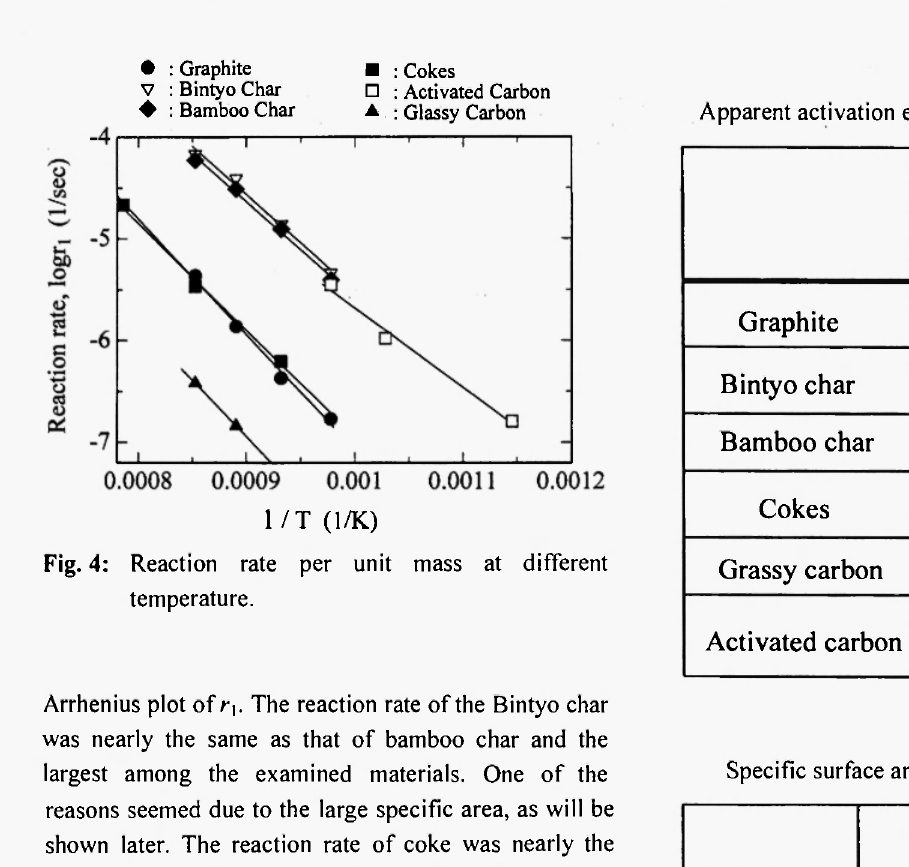
Specific surface area estimated by BET